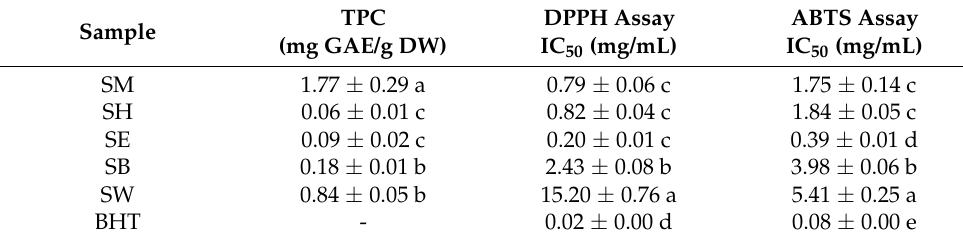
Table 1. Total phenolic contents (TPC) and antioxidant activity of extracts from C. speciosa .